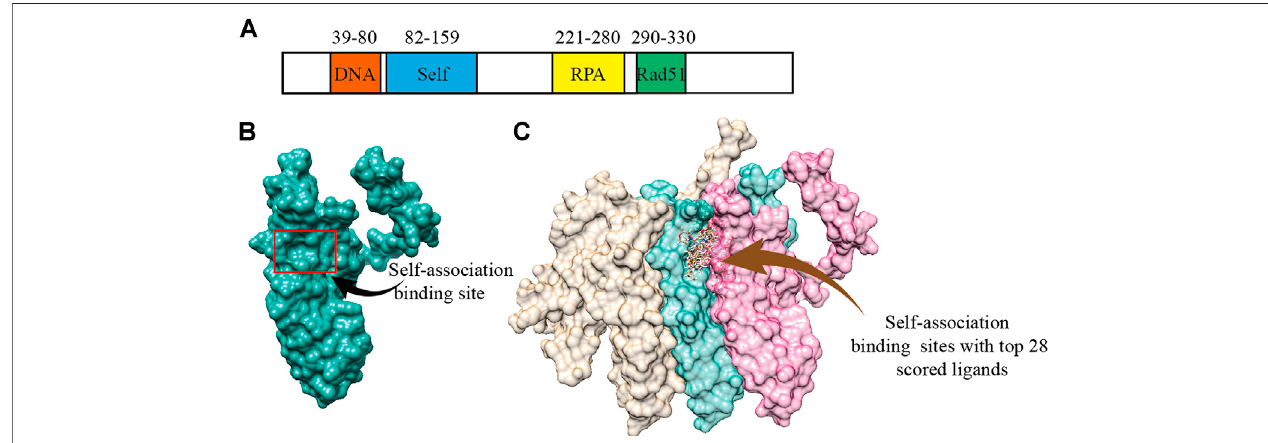
FIGURE1| HumanRAD52self-associationbindingsites. (A) FunctionaldomainsofRAD52protein. (B) Three-dimensionalstructureofRAD52protein;theredbox isthegroove structure de fi nedasthepotentialRAD52self-associationsite. (C) Top28smallmoleculeswiththehighestdocking scorebound totheself-associationsite of RAD52. The three colored structures represent three RAD52 monomers.